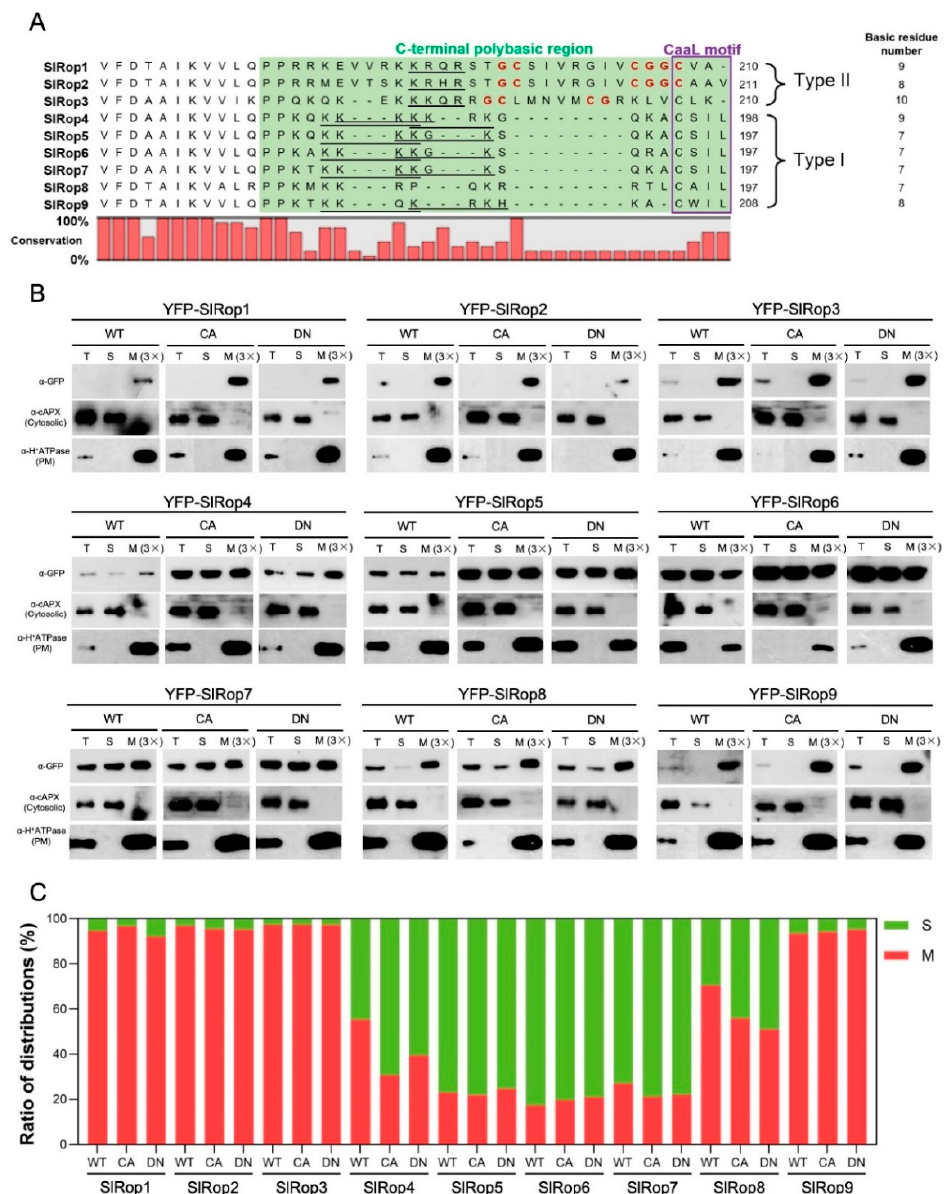
Figure 2. Analysis of the PBRs and subcellular localization of SlRop1–9. ( A ), Amino acid sequence alignment of the C-terminal polybasic regions (PBRs) of tomato Rac/Rop family proteins. The C-terminal PBRs are highlighted with a green background. The purple box indicates the position of the CaaL motif. Red bold letters represent GC-CG box motif. The NLS sequences are underlined. The numbers on the right denote the total basic residues in PBRs. The nine Rops in tomato are subdivided into two types (Type I: SlRop4–9; Type II: SlRop1–3) based on whether they contain the CaaL motif. ( B ), Subcellular distribution of tomato Rho-like small GTPases in N. benthamiana . Agrobacterium carrying YFP-fused SlRop1–9 wild type and mutants were individually injected into tobacco leaves. WT, wild type; CA, constitutively active; DN, dominant-negative; PM: plasma membrane; T: total extract, S: soluble fraction, M: microsomal fraction. M (3×) indicates three times enrichment relative to S. Immunoblotting was performed with anti-GFP (for SlRops), anti-H + ATPase (PM marker), and anti-cAPX (cytoplasm marker) antibodies. ( C ), Ratio of membrane and cytosolic distributions of YFP-SlRops. Red and green bars indicate the percentage of membrane and cytosolic fractions, respectively. S: soluble fraction, M: microsomal fraction. The experiment was repeated twice.